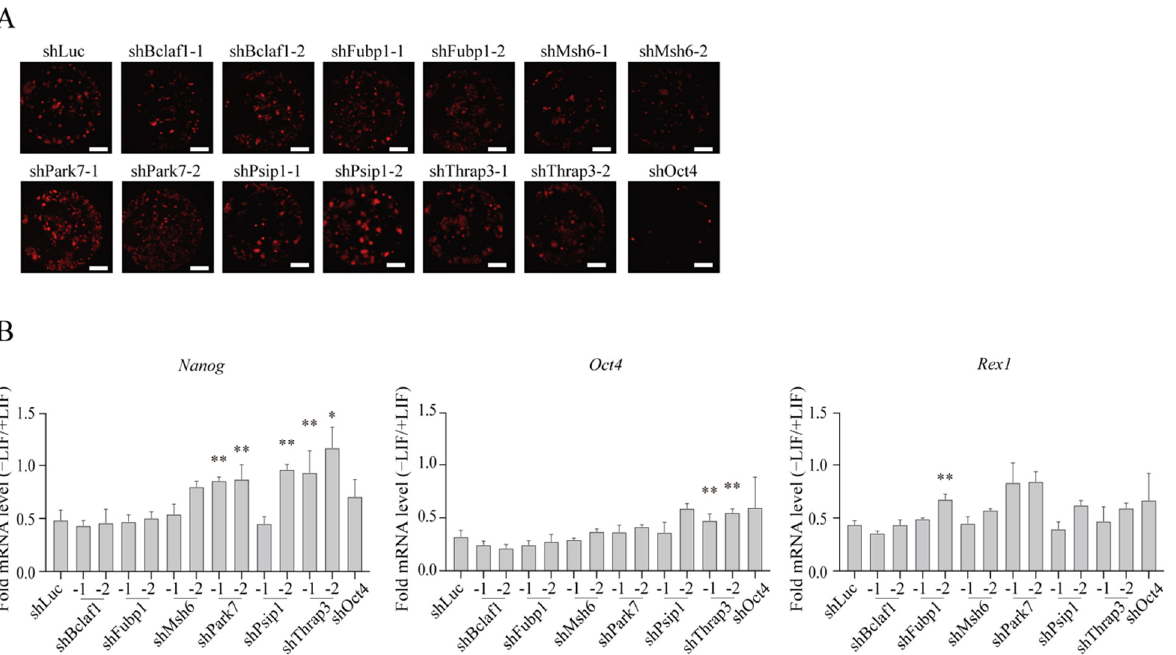
Figure 4. Effect of knockdown of identified proteins on loss of pluripotency. ( A ) Whole well fluorescence images of hKO(+) mESC colonies cultured without LIF. EB5/ReKO cells treated with indicated shRNA and cultured in mESC medium without LIF. Whole well images were collected 9 days after cell sorting. Representative images are shown. Scale bars, 1500 µm. ( B ) mRNA level of pluripotency-related genes. Nanog , Oct4 , or Rex1 mRNA levels in the EB5/ReKO cells prepared as ( A ) were determined 9 days after cell sorting. Data represent the mean ± SEM of three independent experiments. * p < 0.05, ** p < 0.01 versus EB5/ReKO cells treated with control shRNA (shLuc).